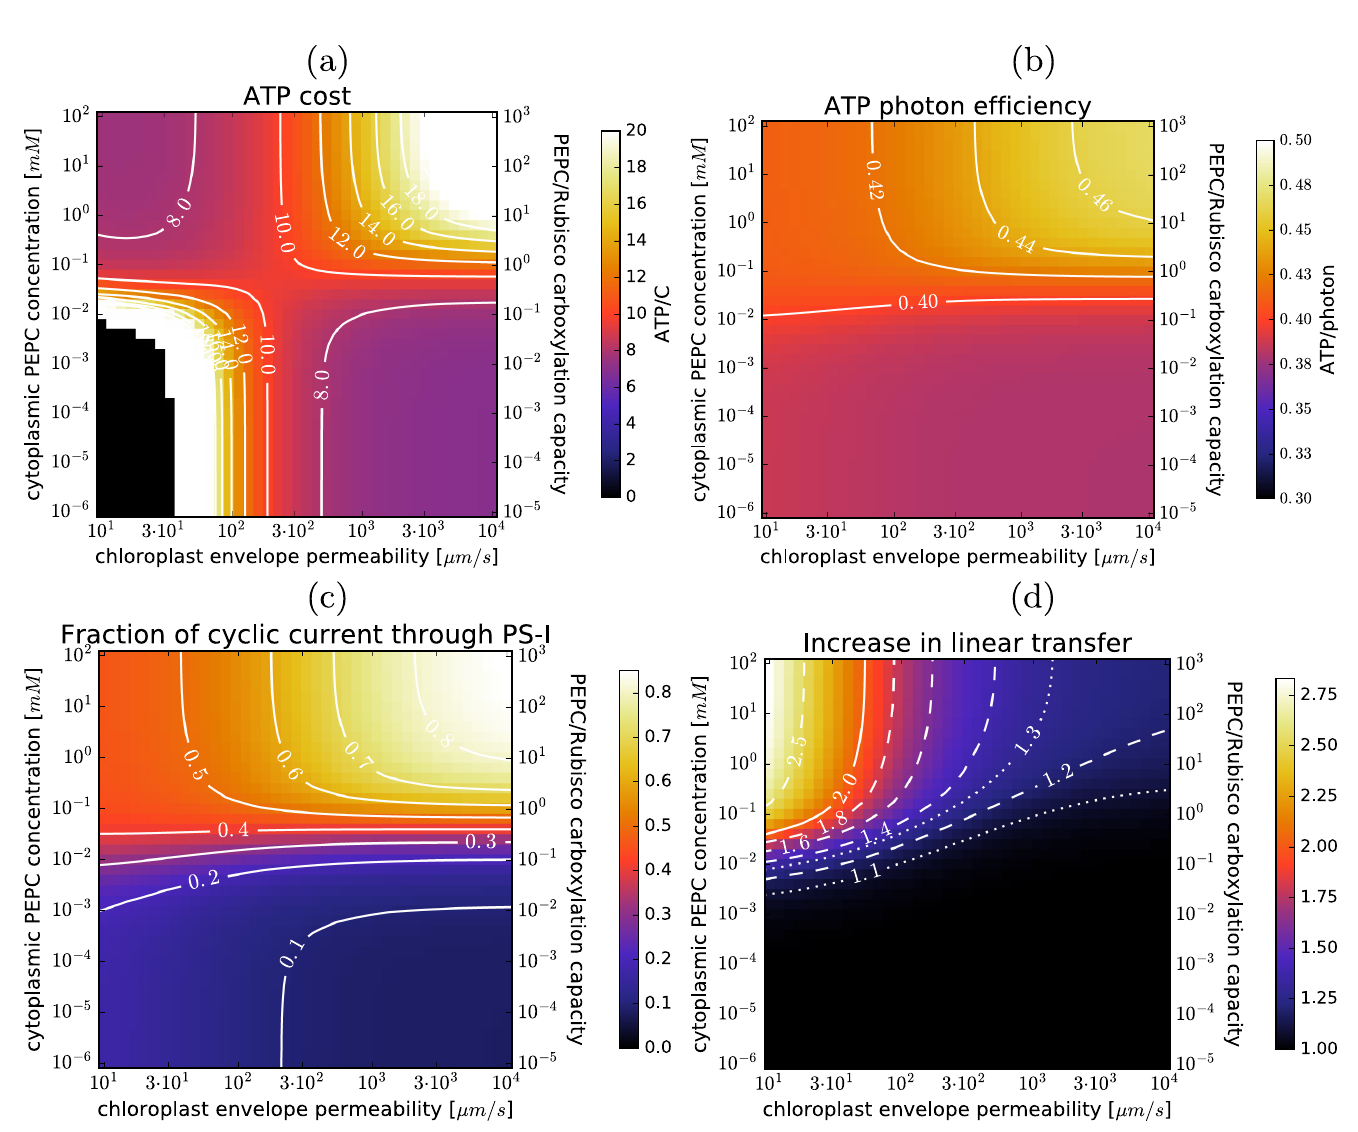
Fig 3. ATP use and electron transfer current. (a) ATP consumption per assimilated carbon; (b) ATP production per photon; (c) the fraction of electron current through PS-I due to cyclic transfer; and (d) the increase in the total linear electron transfer current (relative to C 3 photosynthesis). Level-lines are in white. The dependence on the envelope permeability and PEPC concentration in the cytoplasm is shown, with the default parameter choice (same as in Fig 2).